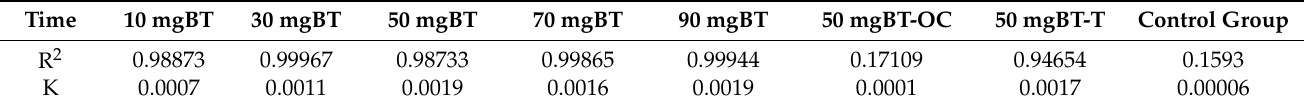
Table 1. The value of the correlation coefficient R 2 and constant k of the kinetic